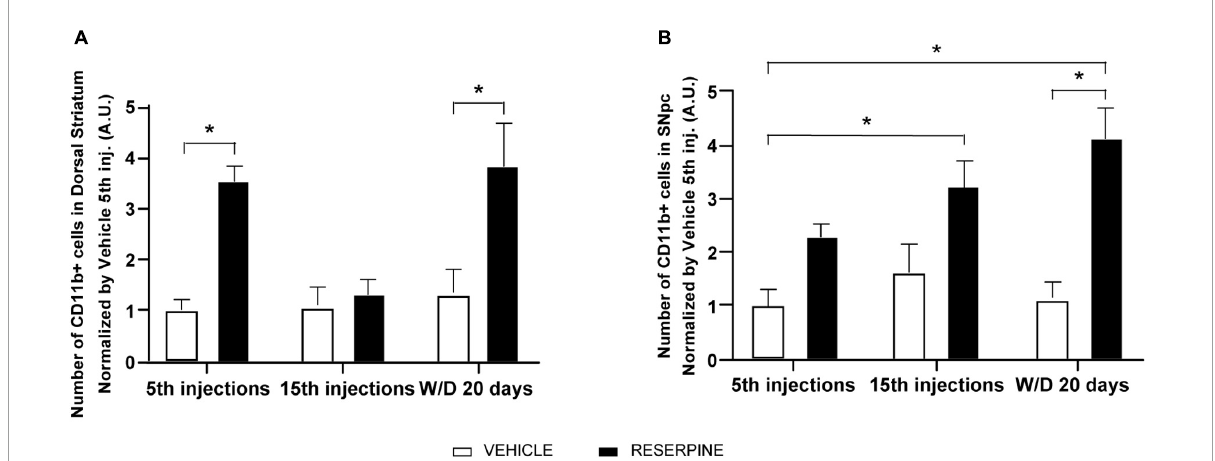
FIGURE6 Effects of repeated administration of 0.1 mg/kg reserpine ( n = 3) on number of CD11b + cells in Dorsal Striatum (A) e SNpc (B) . Data are shown as mean + SEM, * p < 0.05 comparing Reserpine and Vehicle groups (ANOVA followed by Sidak’s test).